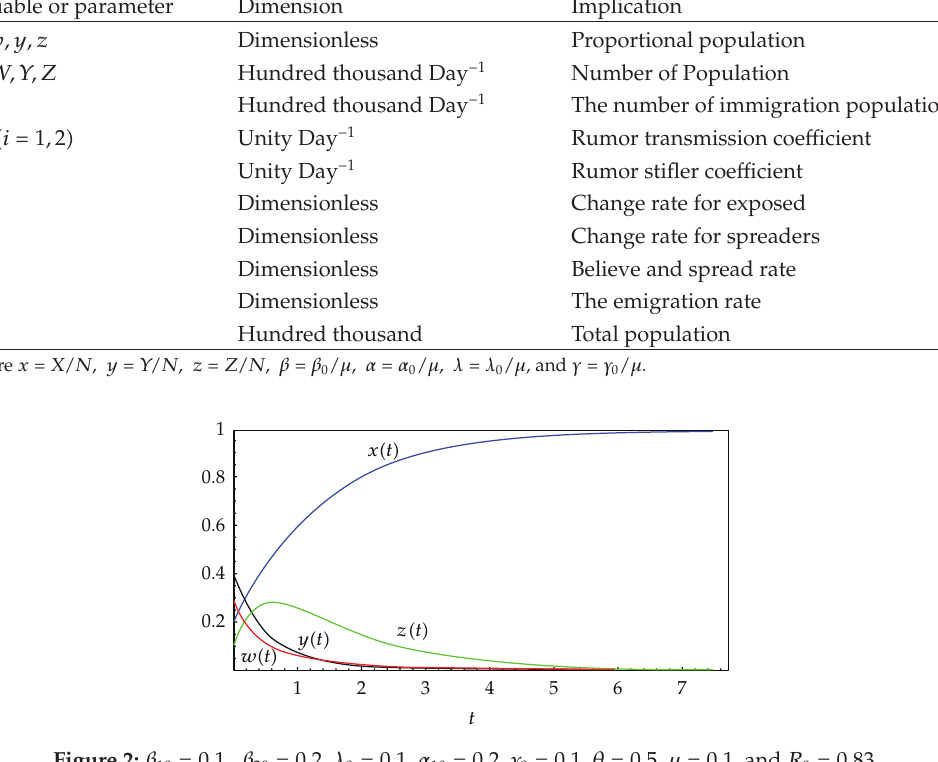
Figure 2: β 10 (cid:3) 0 . 1 , β 20 (cid:3) 0 . 2, λ 0 (cid:3) 0 . 1, α 10 (cid:3) 0 . 2, γ 0 (cid:3) 0 . 1, θ (cid:3) 0 . 5, μ (cid:3) 0 . 1, and R 0 (cid:3) 0 .